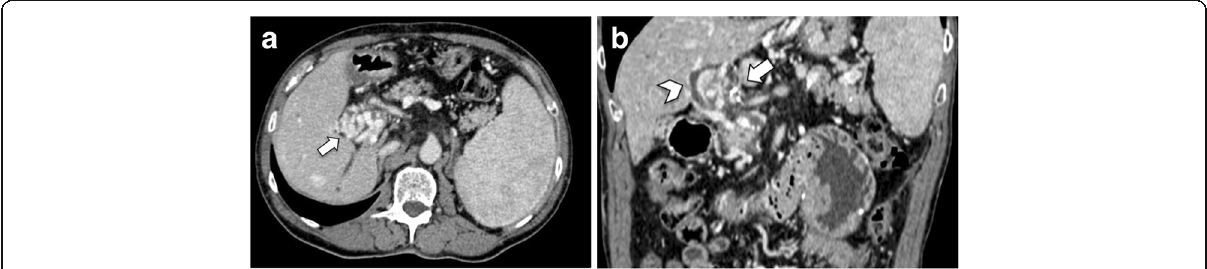
Fig. 19 A 63-year-old woman with portal biliopathy. a Axial enhanced CT image shows the cavernous transformation of the portal vein (arrow). b Coronal CT image demonstrates biliary ducts dilatation (arrowhead) due to compression by portal cavernoma